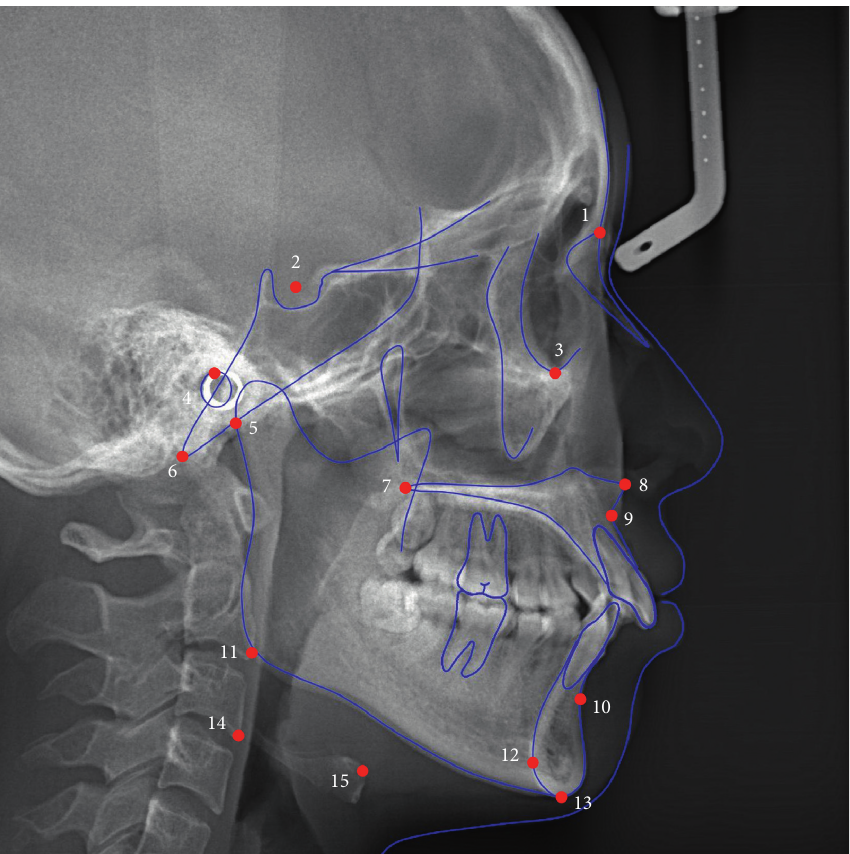
Figure 1: Landmarks used in this study. (1) N: nasion; (2) S: sella; (3) Or: orbitale; (4) P: porion; (5) Ar: articulare; (6) Ba: basion; (7) PNS: posterior nasal spine; (8) ANS: anterior nasal spine; (9) A: A point; (10) B: B point; (11) Go: gonion; (12) RGn: most protrusive point of retrognathion; (13) Me: menton; (14) C3: most anterior and inferior point of the third cervical vertebra; and (15) Hy: most anterior and superior point on the body of the hyoid